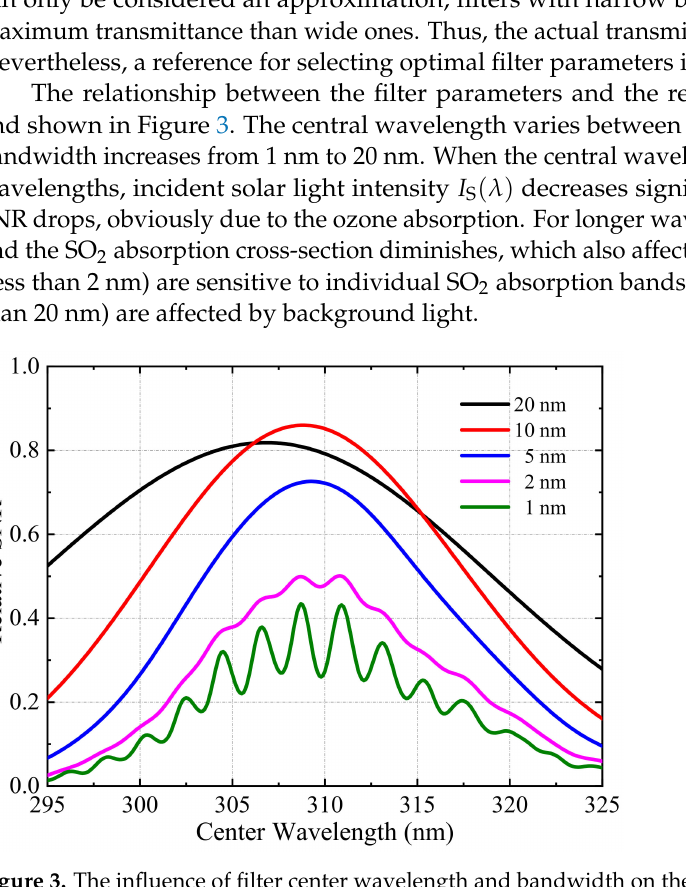
Figure 3. The influence of filter center wavelength and bandwidth on the relative SNR of the camera. Different colors represent different filter